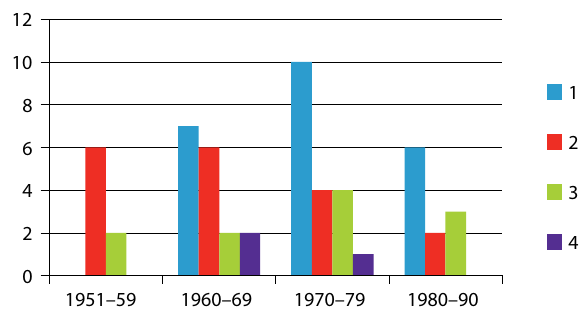
fig. 2. Distribution of research fields and its